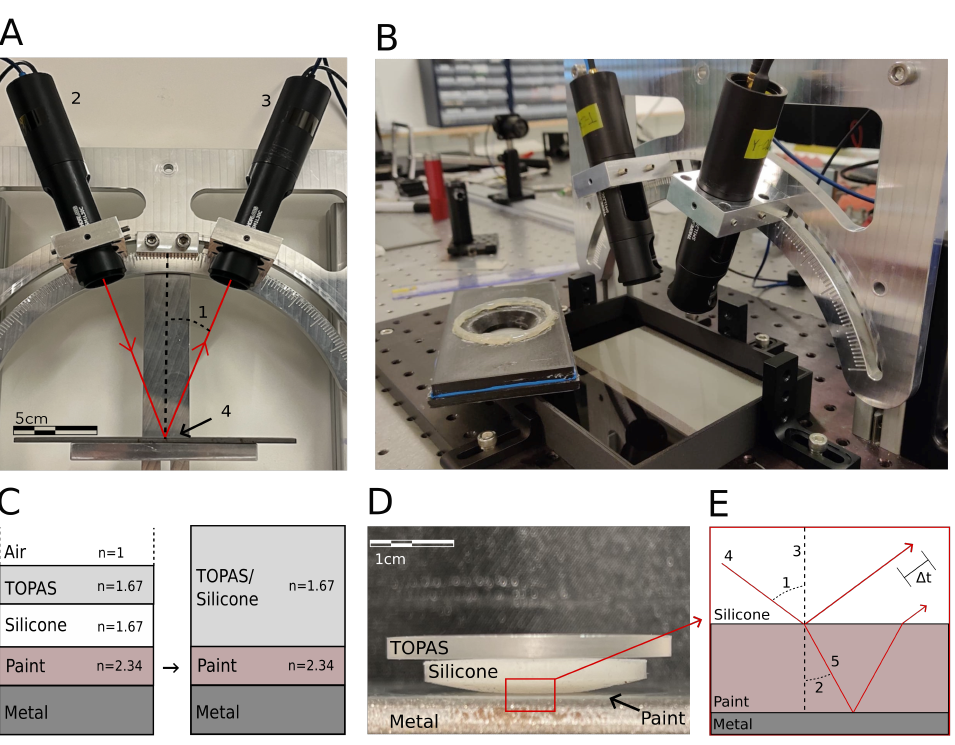
Figure 2. ( A ) Traditional reflection setup with the paint placed at the focal point (4) of the transmitting (2) and receiving (3) antennae. The antennae are set at an angle of incidence of 20° (1) and use the s-polarization. ( B ) The silicone and TOPAS plastic contact patch on top of the paint sample. In the measurements, the contact patch was encased in a 3D-printed device, which enabled pressure to be applied to the silicone. ( C ) Zoomed-in version of the illustration on how the thickness can be derived from the difference in arrival time ( ∆ t ) of the two reflections, described by Equation (1). ( D ) The TOPAS and silicone layers on the paint, without the 3D-printed holder. ( E ) A simplification of the physical model was made to reduce the